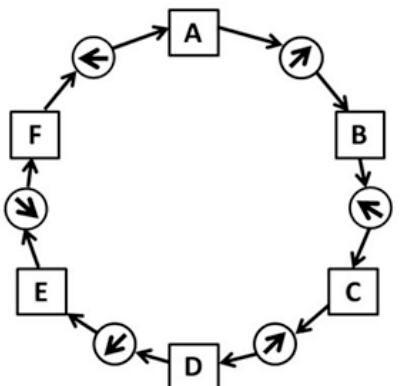
Figure 1a. Scanpath Theory-Feature Ring. Eye fixations shown as connected sequence resulting in a sequential string of visited regions of interest (ROIs) (lettered squares) and saccadic eye movements (circles with arrows) shown by solid